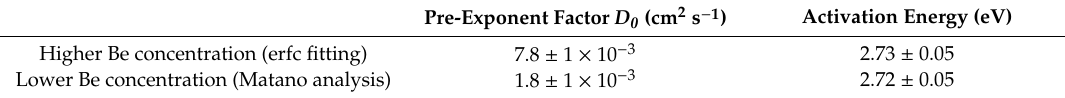
Table 1. Temperature-independent pre-exponent factor D 0 and the activation energy for the Be di ff